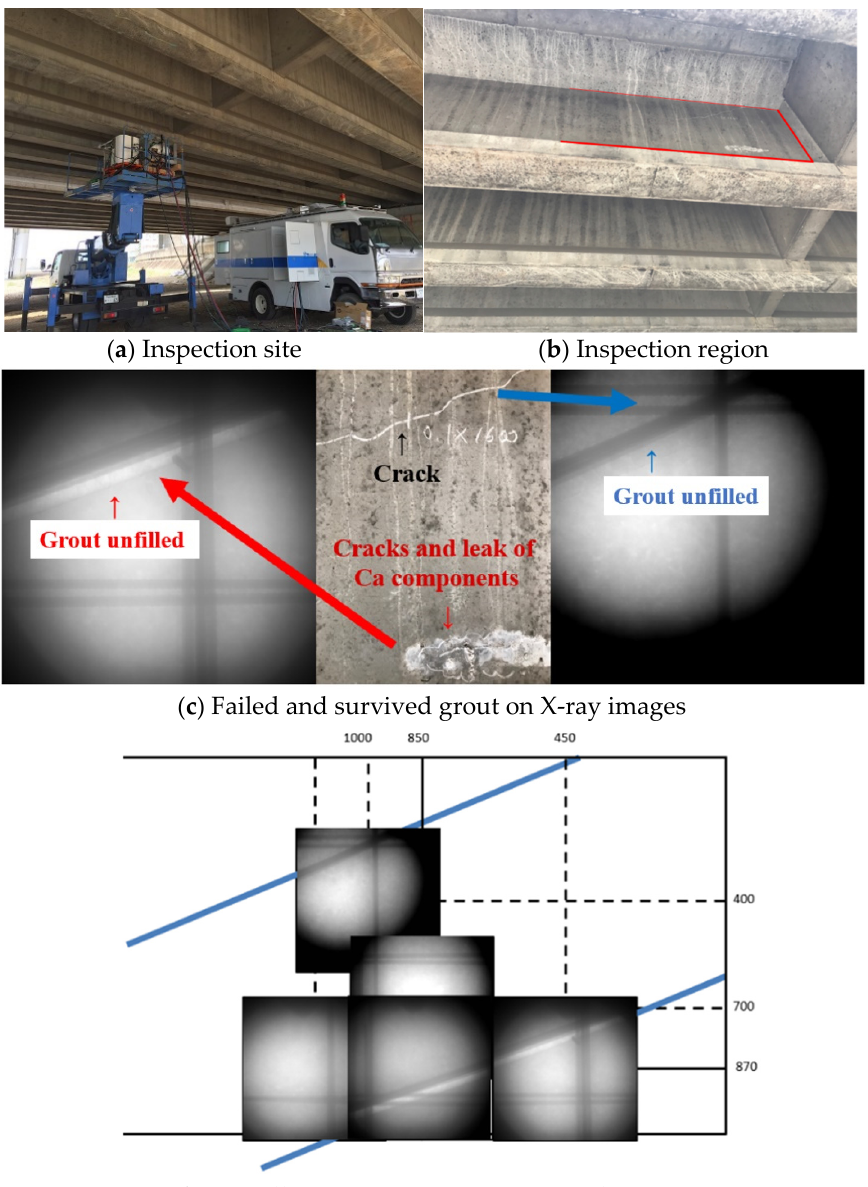
Figure 12. Photographs of onsite inspection and measured X-ray images by 950 keV X-ray source for a T-shape PC girder bridge. ( a ) Way of inspection; ( b ) inspection region; ( c ) filled and unfilled grouts in the X-ray images; ( d ) overall situation composed by several images.